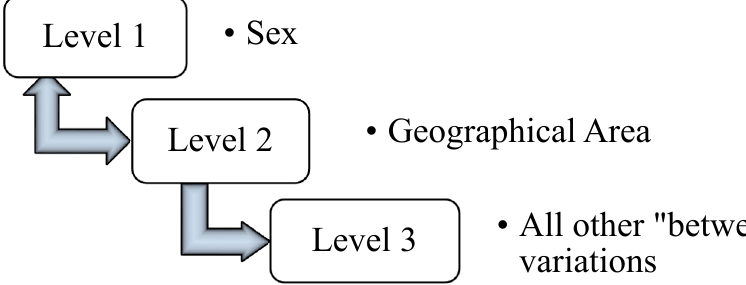
Figure 3. Schematic of the multilevel model used here. This is a non-nested model, i.e., there is no natural “nested order” to sex and geographical area (shown by the “double arrows” appropriately).